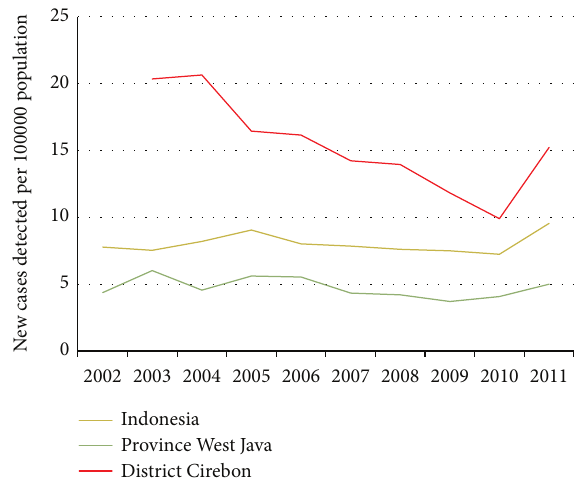
Figure 1: 10-year trend of new case detection rate in Indonesia, West Java and Cirebon in 2002–2011 (data is merged from [21,